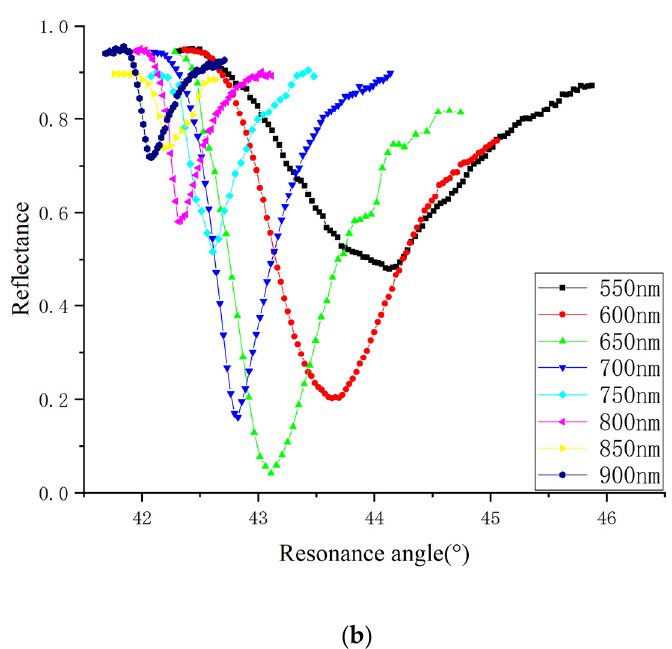
Figure 4. The shift in reflectance with the resonance angle under the different wavelengths: ( a ) 45 nm silver nano-film; ( b ) 45 nm gold nano-film.